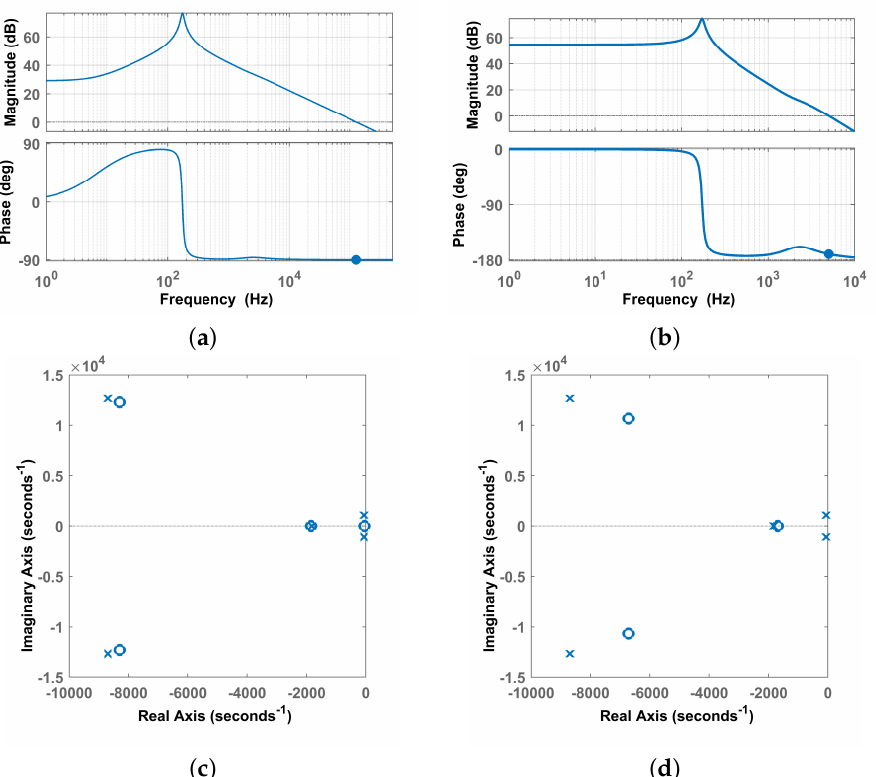
Figure 11. TF boost mode for: ( a ) Bode plot Gi L 1 d _ u _ RC ( s ) . ( b ) Bode plot Gvd _ u _ RC ( s ) . ( c ) Pole and zero map for Gi L 1 d _ u _ RC ( s ) . ( d ) Pole and zero map for Gvd _ u _ RC ( s ) .